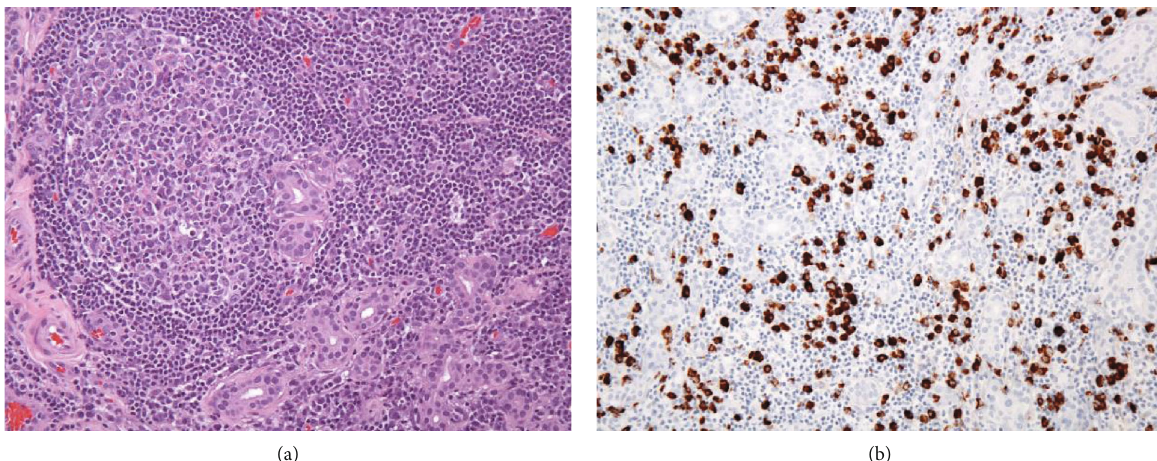
Figure 2: (a) Lacrimal gland obliterated by dense lymphoplasmacytic in fi ltrate containing reactive lymphoid aggregate (H&E, 200x). (b) IgG4 immunohistochemical stain showing abundant IgG4+ plasma cells (IgG4,